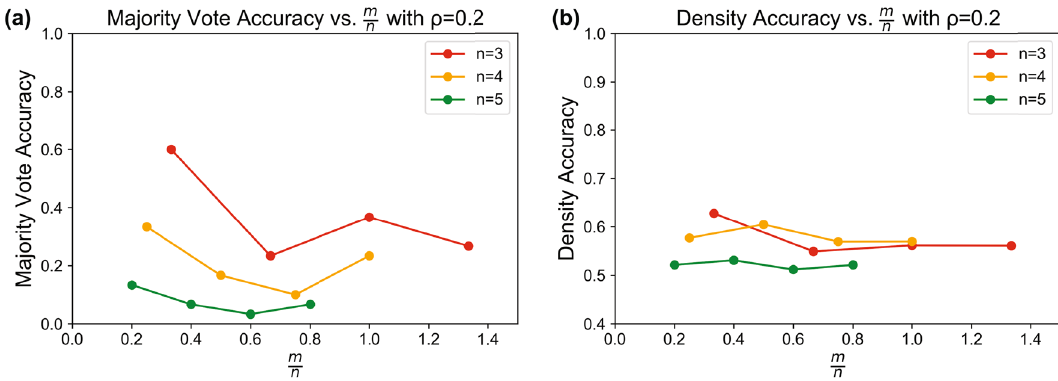
Figure 9. Effective QHAM capacity using ibmq_16_melbourne 40 hardware. ( a ) Majority vote accuracy for the QHAM in hardware for n same test conditions as ( a ) versus m / n